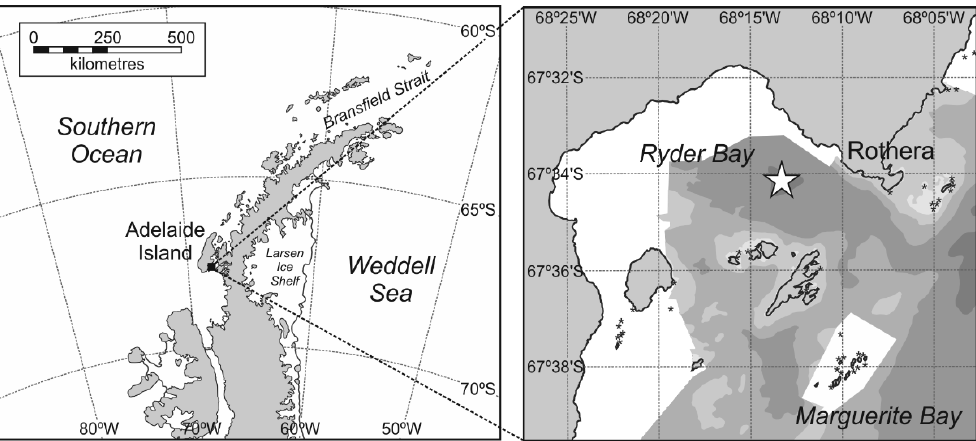
Figure 1. Map of the Western Antarctic Peninsula illustrating the location of the sampling site (white star), west of the British Antarctic Survey’s Rothera Research Station at 67.570° S 68.225° W. Phytoplankton, bacterioplankton, viral and heterotrophic nanoflagellate abundances. Chlorophyll concentrations were obtained using a WetLabs in-line fluorometer (see